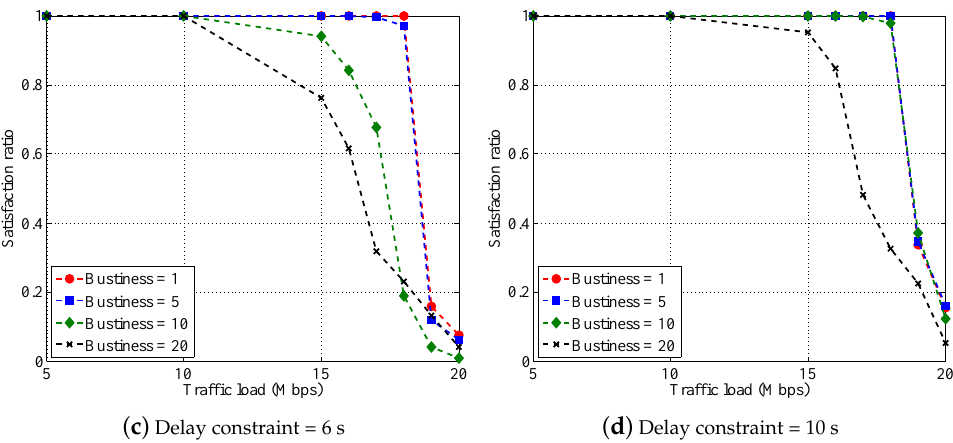
Figure 6. The satisfaction ratio when the spectral efficiency is 3 bps/Hz when the traffic load varies from 5–20 Mbps and burstiness varies from 1–20 (VBDC).